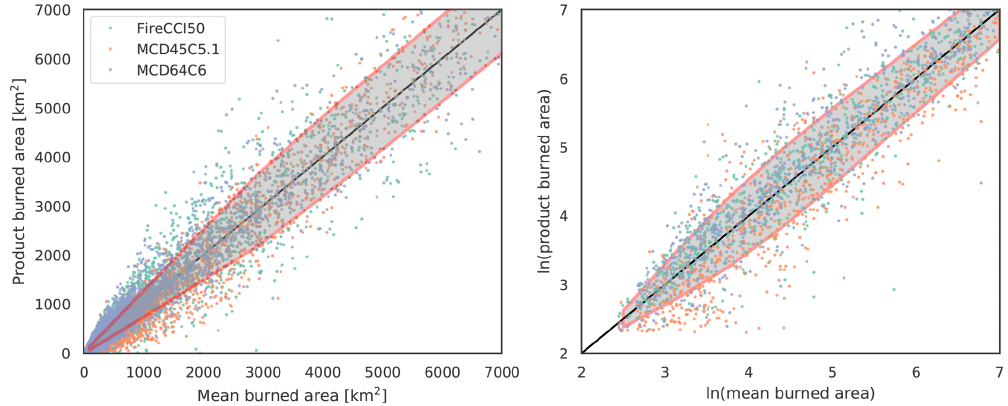
Figure 1. Differences between the burned area reported by the three products and the mean of the three products. Also shown is the standard deviation of the products (grey) binned by the mean burned area of the three products. Increasing standard deviation with the magnitude of burned area implies heteroscedastic errors, while log-transformed burned areas have errors which are more